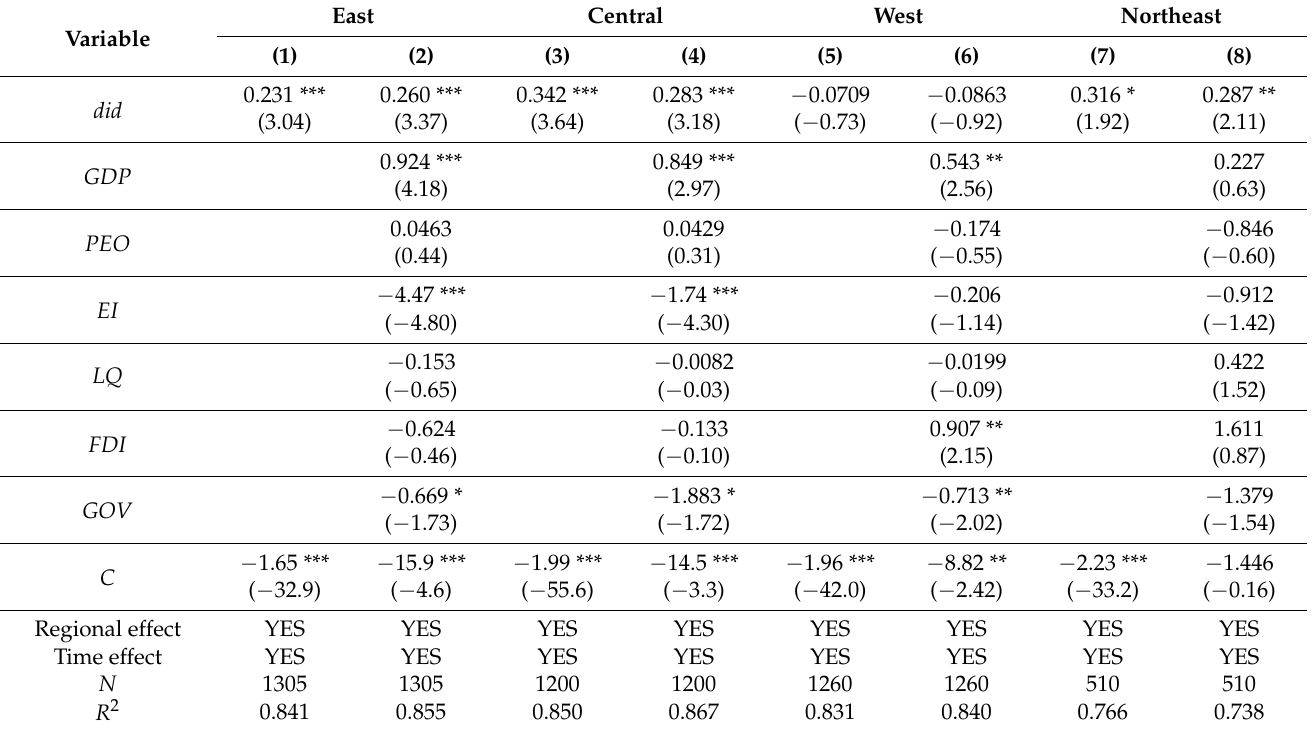
Table 7. Estimation results of multi-period DID models by